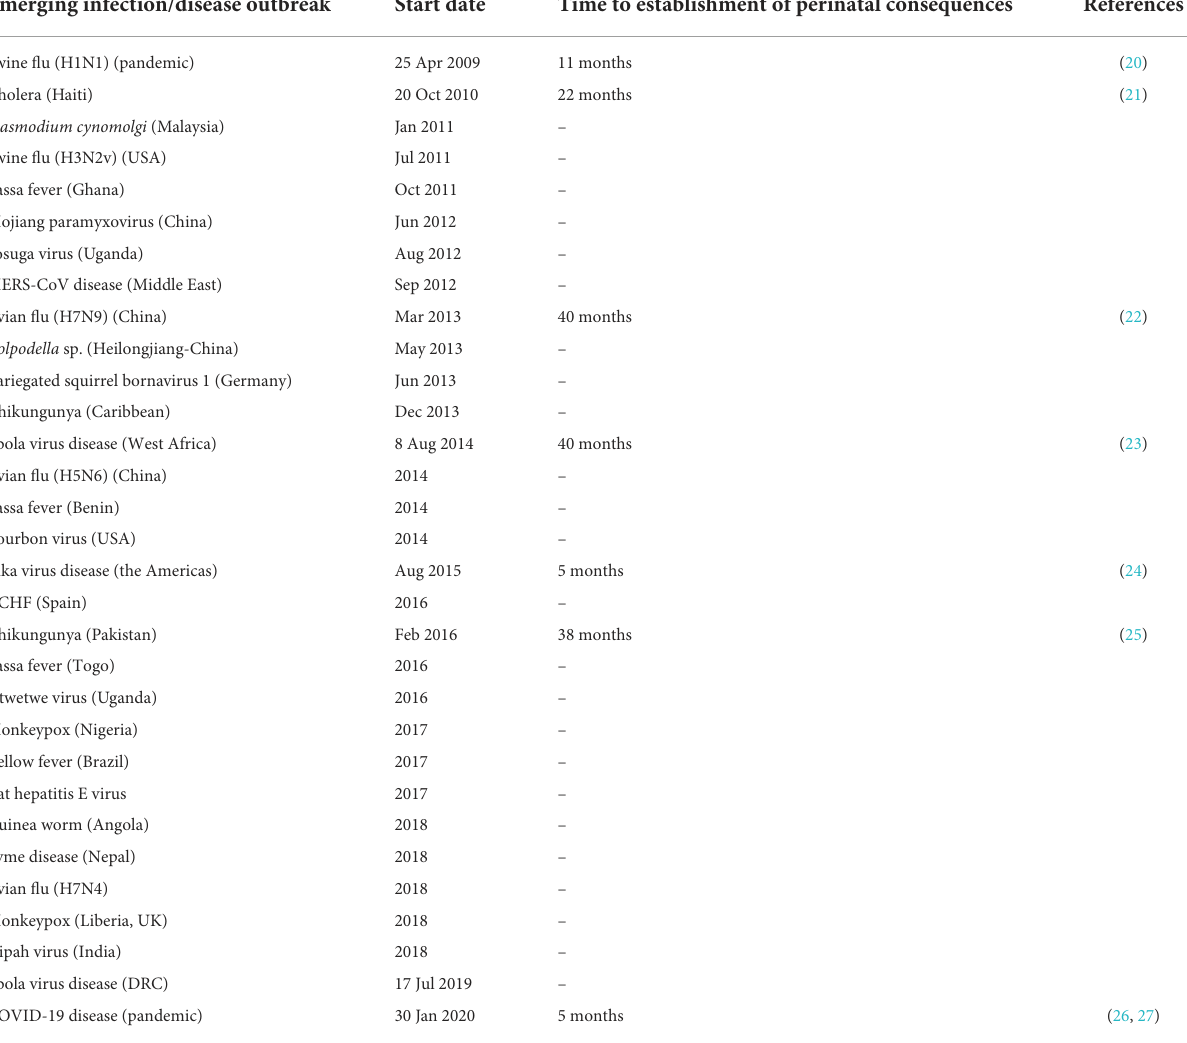
TABLE 3 Time of establishing perinatal consequences (first cohort or case-control report) from the start of a disease outbreak (declaration date or month of first cases) for emerging disease outbreaks since